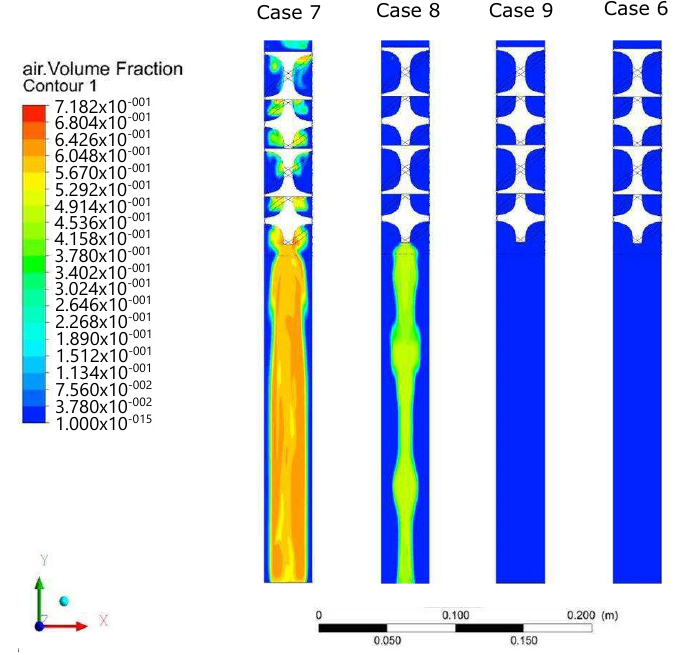
Figure 8. Air distribution in cases with gas.